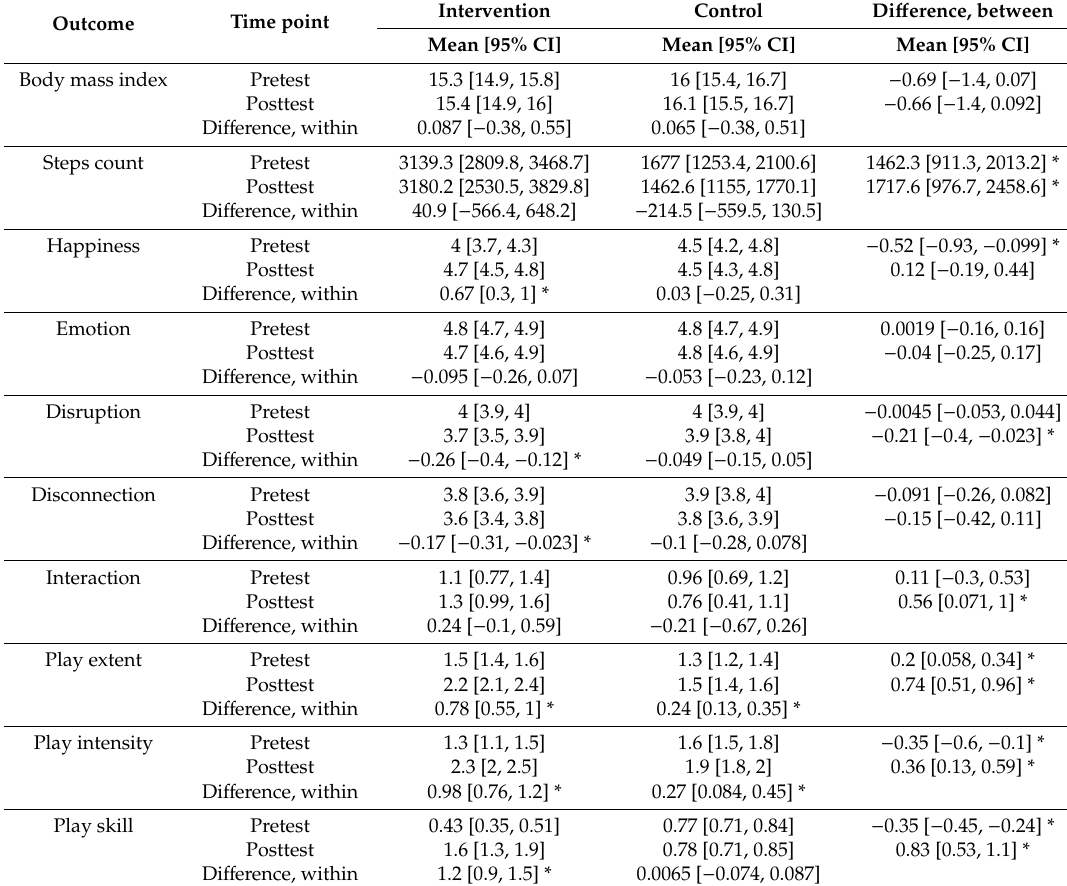
Table 3. Least squares means of physical and psychosocial variables between groups across time. Intervention Control Di ff erence, between Outcome Time point Mean [95% CI] Mean [95% CI] Mean [95%